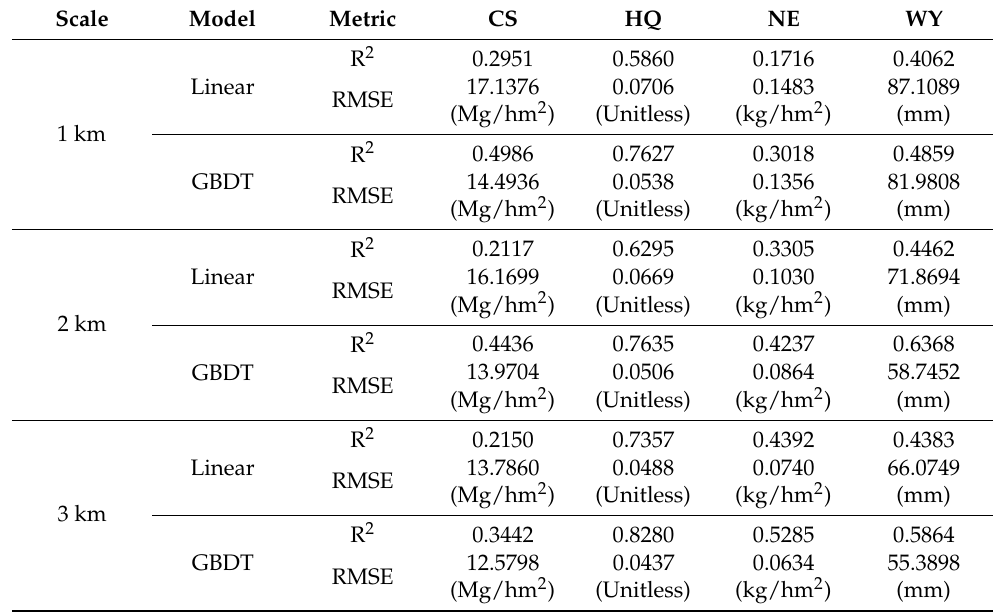
Table 3. Comparison of the GBDT model and linear regression